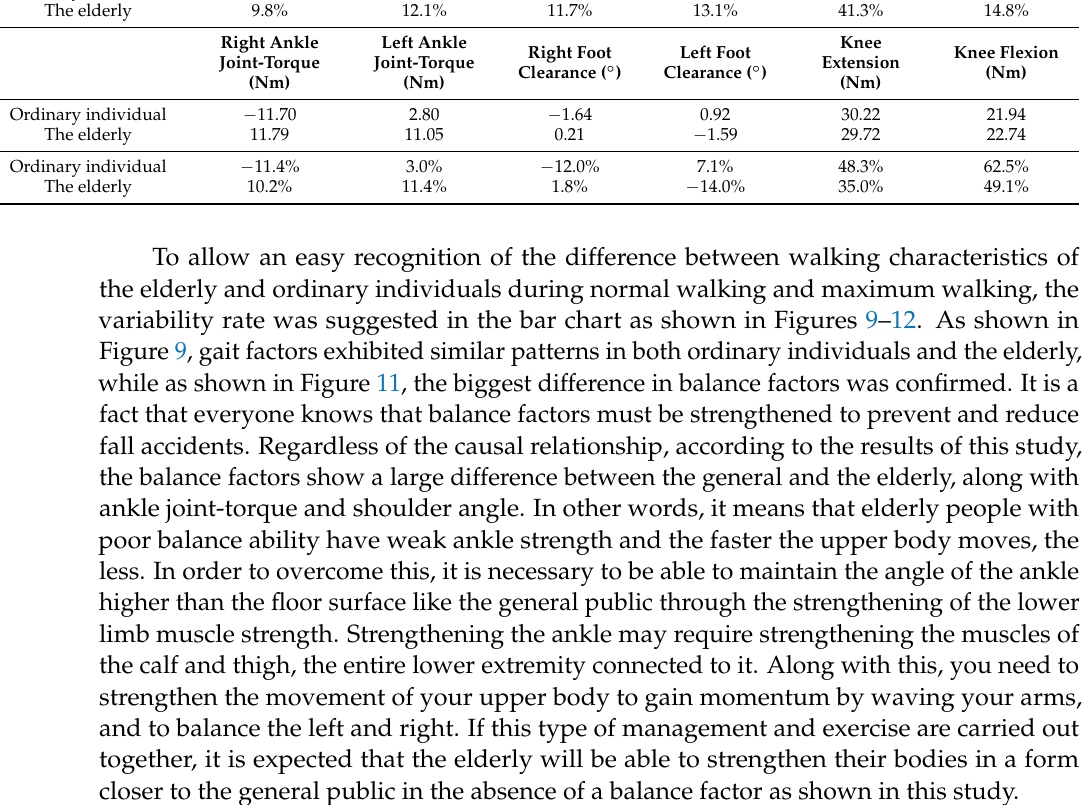
Figure 10. Muscle factor. Figure 11. Balance factor. Figure 12. Angle factor. 6. Results and Conclusions As South Korea has become an aging society, a continuous growth in the socioeco- nomic activity of the elderly is expected [3]. In this case, the elderly naturally experienced a reduction in the walking ability when compared with the ordinary individuals, even